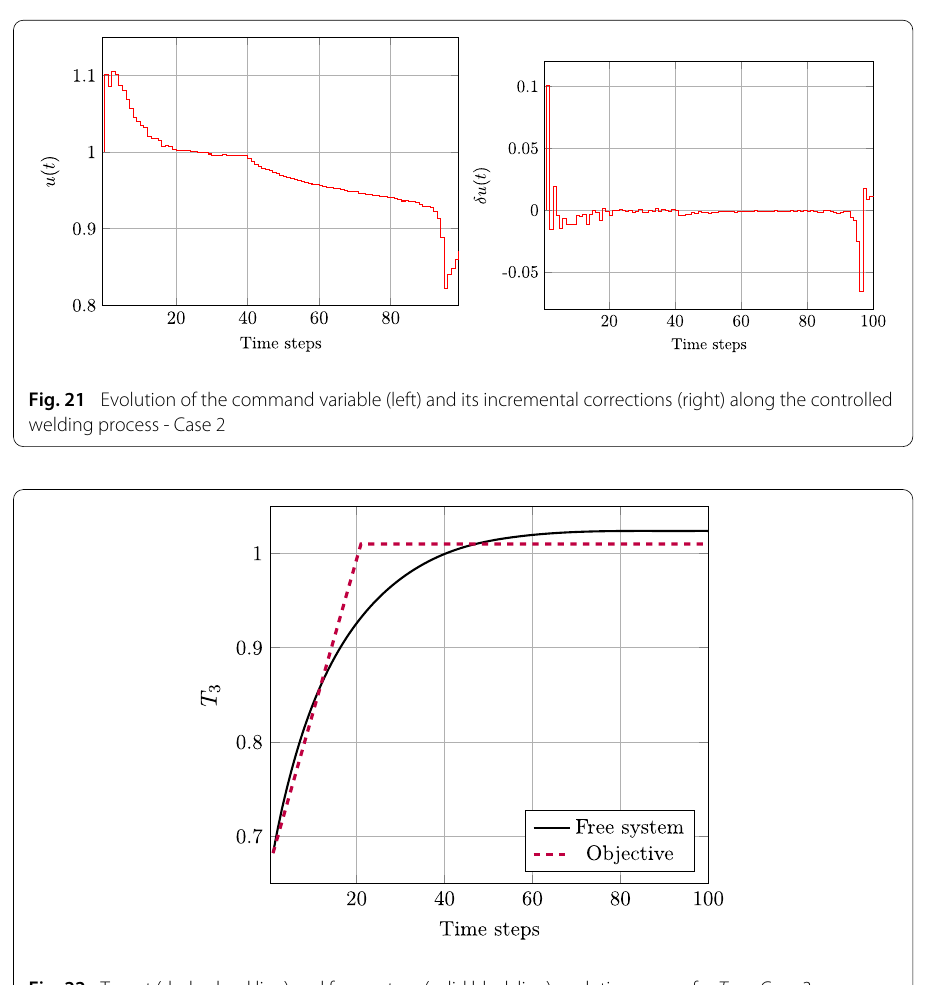
Fig. 22 Target (dashed red line) and free system (solid black line) evolution curves for T 3 | t - Case